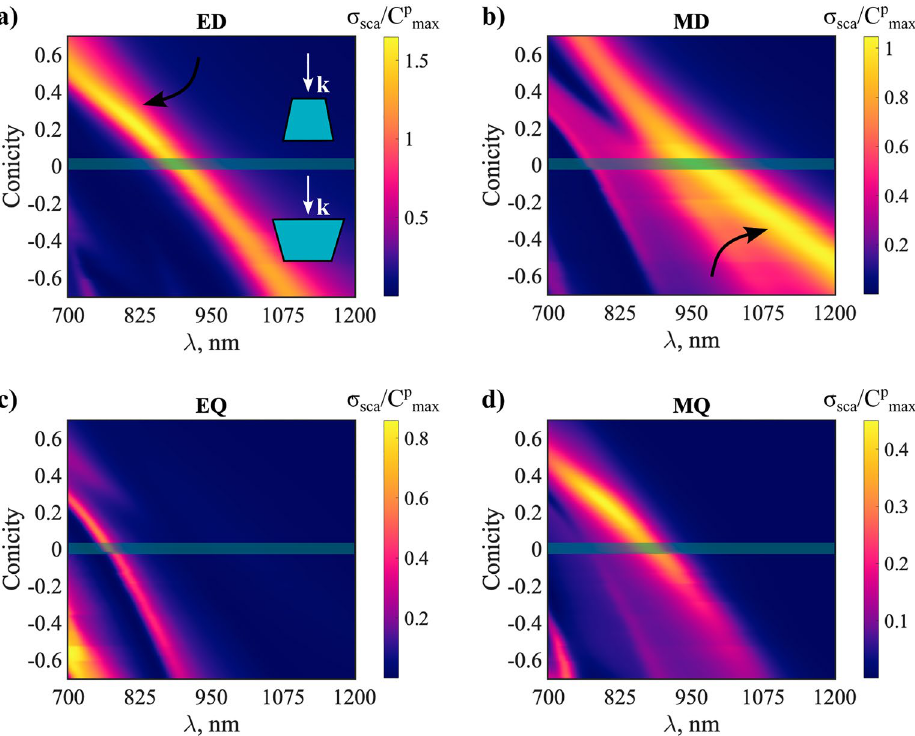
Figure 10. The multipole contributions to total scattering of the cone setup presented in Fig. 9 with ED ( a ), MD ( b ), EQ ( c ), and MQ ( d ). The shaded green line corresponds to the unperturbed cylinder (conicity = 0). The two black arrows point to the regions of maximum of electric dipole and magnetic dipole contributions in the lower and upper branches of modes M 1 ’ and M 2 ’ interference. Material is considered dispersionless ( n = 3.45) for calculations simplicity